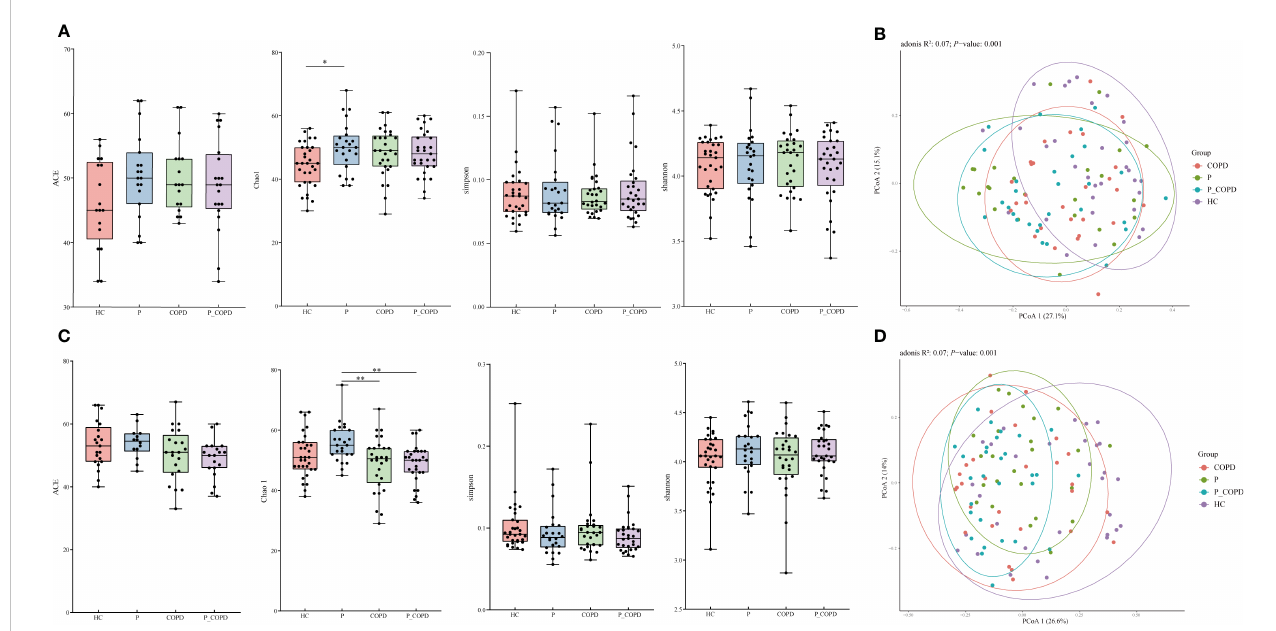
FIGURE 1 Alpha diversity analysis of healthy controls (HC), periodontitis (P) group, chronic obstructive pulmonary disease (COPD) group and comorbid diseases (P_COPD) group. Chao1, Shannon, abundance-based coverage estimator (ACE) and Simpson indices of each group, (A) in subgingival plaque samples and (C) in gingival crevicular fl uid samples. Under Chao1 index, signi fi cant difference between HC and P was observed in subgingival plaque samples, signi fi cant differences between P and COPD, P and P_COPD were observed in gingival crevicular fl uid samples. Principal coordinate analysis (PCoA) among healthy controls (HC), periodontitis (P) group, chronic obstructive pulmonary disease (COPD) group and comorbid diseases (P_COPD) group. (B) The PCoA plot showed a separation of samples from HC and other diseased groups in subgingival plaque samples. (D) The PCoA plot showed a separation of samples from HC and other diseased groups in gingival crevicular fl uid samples. The samples of P_COPD were separated from P group.*: p < 0.05 **: p <